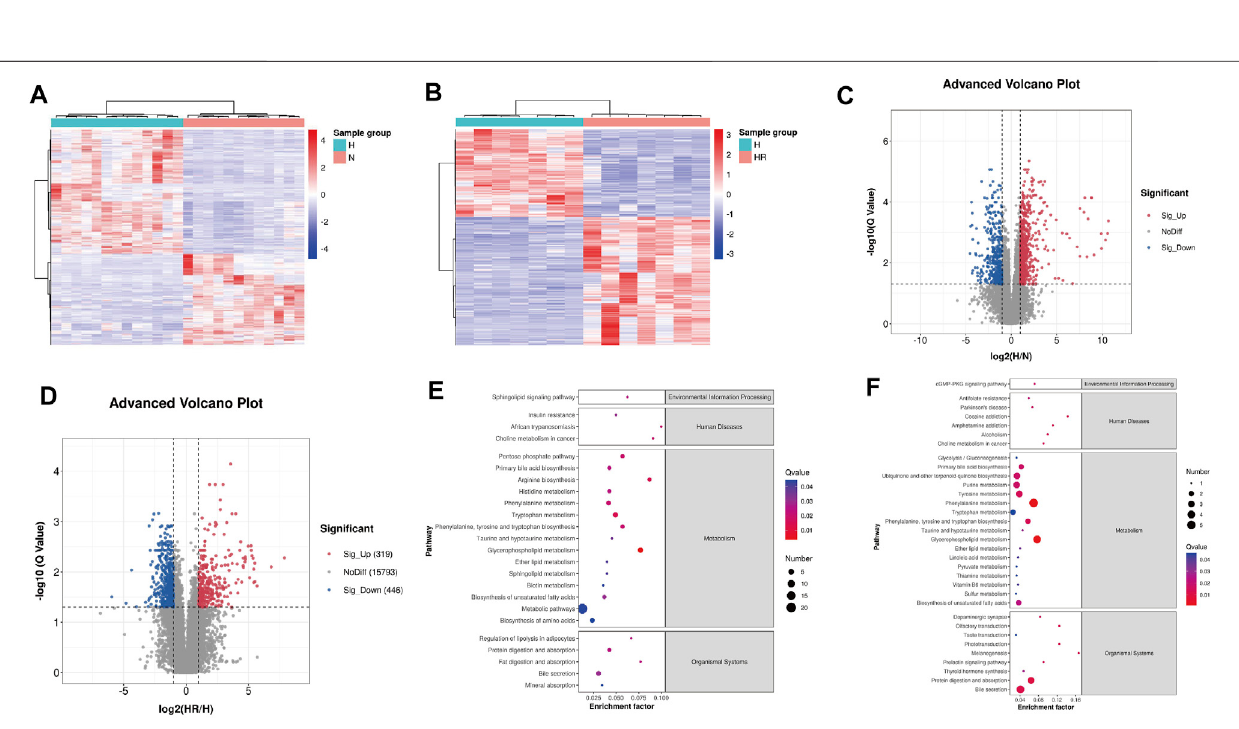
FIGURE 5 | Differential metabolites screened by metabolomics analysis and metabolic pathway analysis. (A) Heat map of differentially expressed metabolites between N and H groups. (B) Heat map of differentially expressed metabolites between H and HR groups. (C) Volcano plots of differentially expressed metabolites between N and H groups. (D) Volcano plots of differentially expressed metabolites between H and HR groups. (E) KEGG enrichment of differentially expressed metabolites between N and H groups. (F) KEGG enrichment of differentially expressed metabolites between H and HR groups. N, normal group; H, high-fat diet group; and HR, high-fat diet plus REV treatment